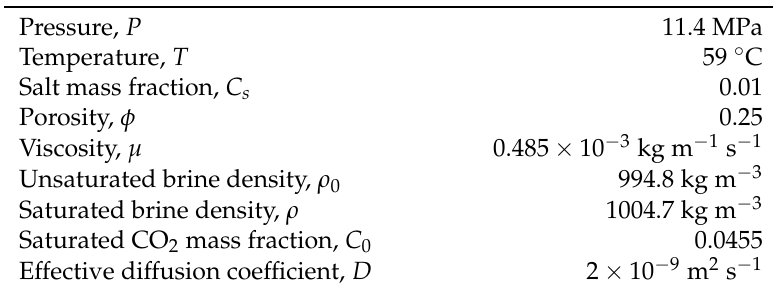
Table 2. Parameters used in the dimensional simulations (representative of a low salinity aquifer at a depth of approximately 1 km).